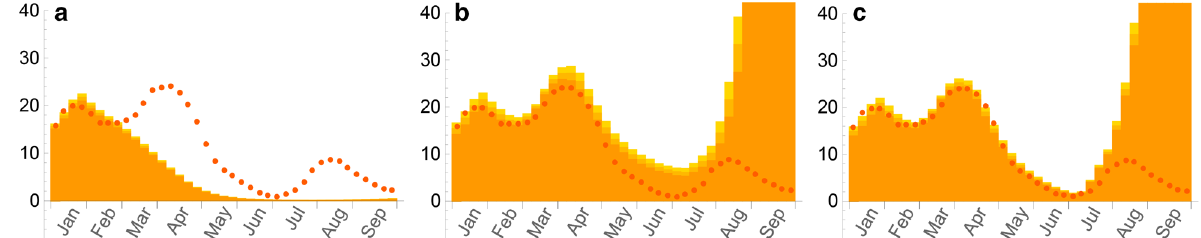
Figure 5. Number of weekly hospital admissions normalized to 50,000 households in three typical scenarii; ( a ) with the SARS-CoV-2 initial strain only and no progressive vaccination campaign; ( b ) with the propagation of the α variant and no progressive vaccination campaign; ( c ) with the propagation of the α and δ variants and progressive vaccination campaign up to the beginning of the δ variant propagation only. The red points correspond to epidemiological data from Santé Publique France 18 and statistical errors at 95% CL are represented by slightly different orange